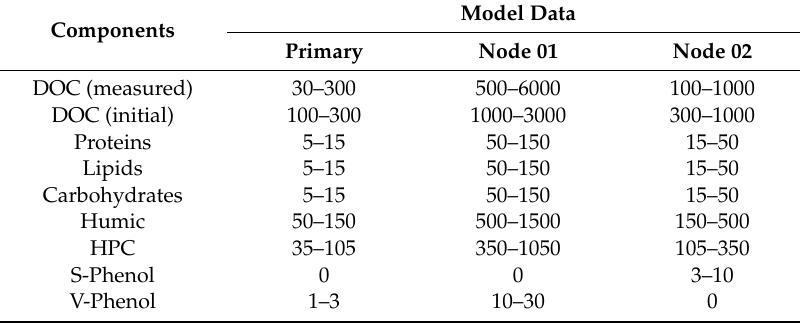
Table 1. Initial class concentrations in micromolar of carbon atoms, leading with total dissolved organic carbon (DOC). Other abbreviations appearing are HPC—heteropolycondensate, and V—vanillyl or S—syringyl for the marker lignin phenolic